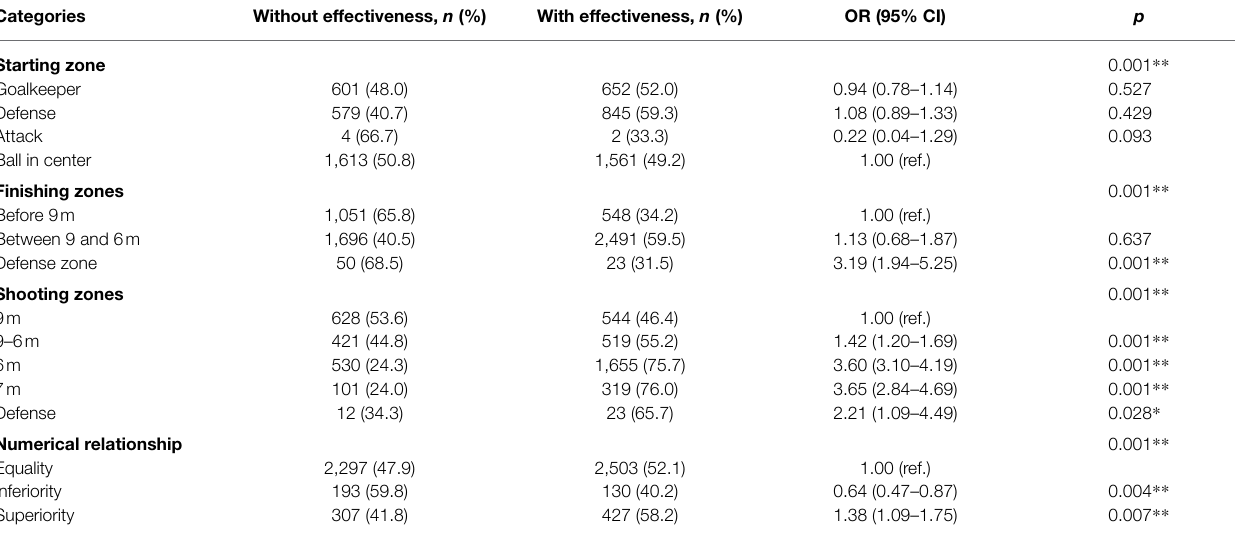
TABLE 5 | Differences in possession outcome according to start, finishing and shooting zones, and numerical